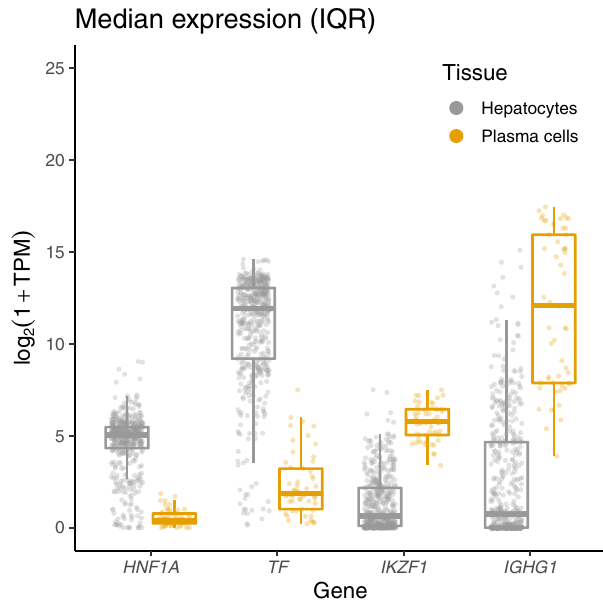
Fig. 5 Expression of TF, IGHG1, HNF1A and IKZF1 in main tissues of transferrin and IgG synthesis (liver and plasma cells). Gene expression data, expressed in gene counts, was scaled to transcripts per million (TPM) and log 2 (1 + TPM) transformed. The data for hepatocyte ( N = 513) and plasma ( N = 53) cell samples were obtained from the ARCHS4 portal 72 . TF encodes transferrin protein, IGHG1 encodes the constant region of immunoglobulin heavy chains, HNF1A and IKZF1 encode two transcription factors involved in glycosylation of transferrin and IgG respectively. In the plot, the middle line represents the median, lower and upper limits of the box represent the fi rst and third quartile, whiskers represent the 1.5 interquartile range. All individual data points are overlapped to the box